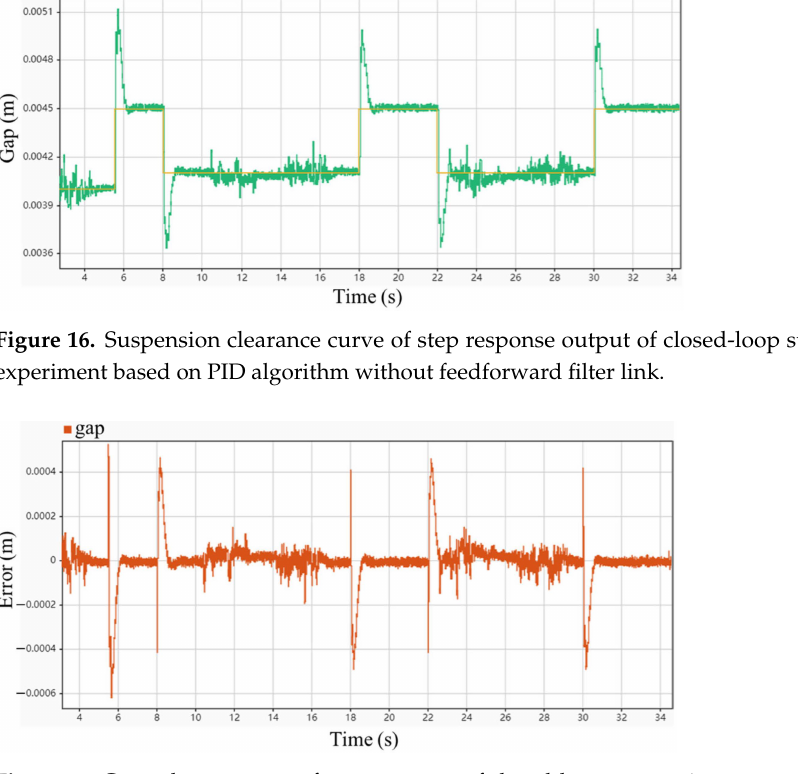
Figure 17. Control error curve of step response of closed-loop suspension system experiment based on PID algorithm without feedforward filter link.